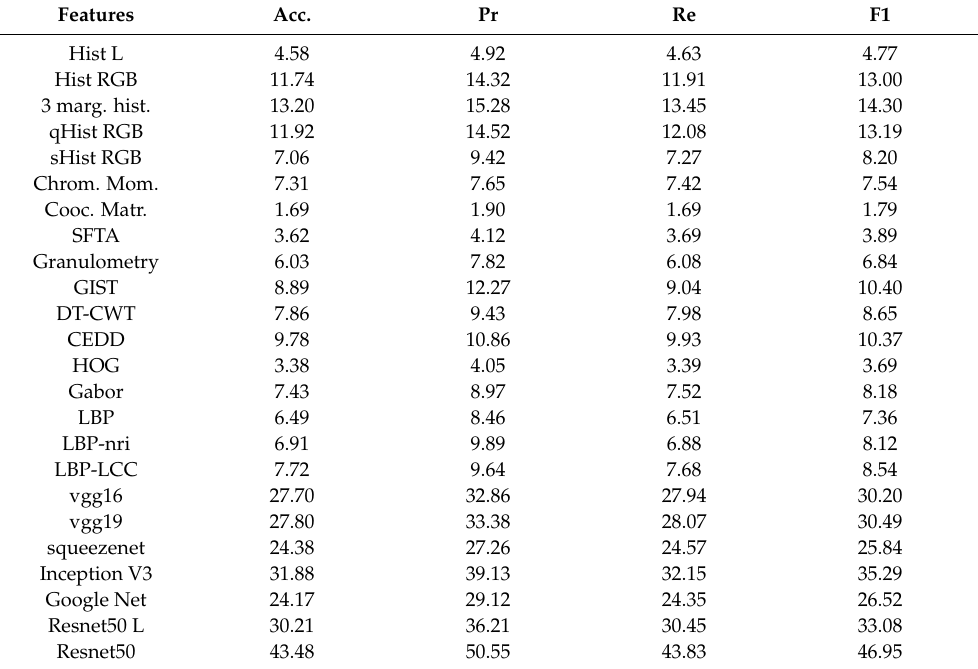
Table 5. One-shot learning using